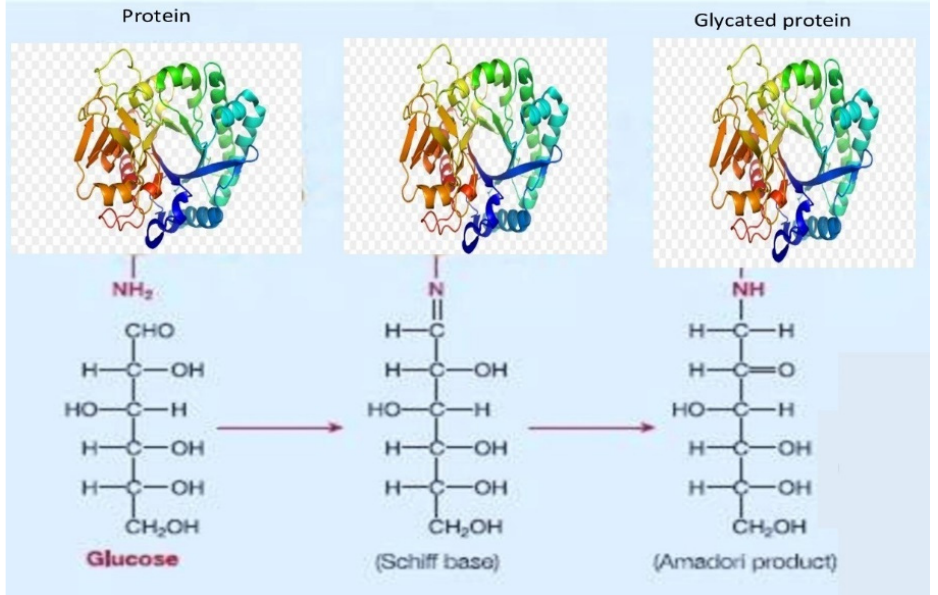
Figure 1. The conjugation process of proteins and sugars.